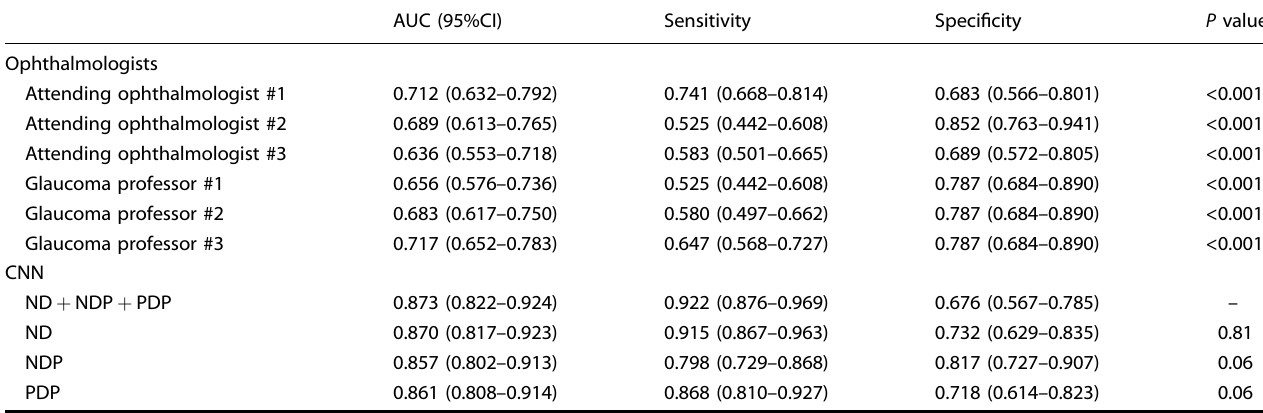
Table 2. Performance of the CNNs and ophthalmologists in test set 1.